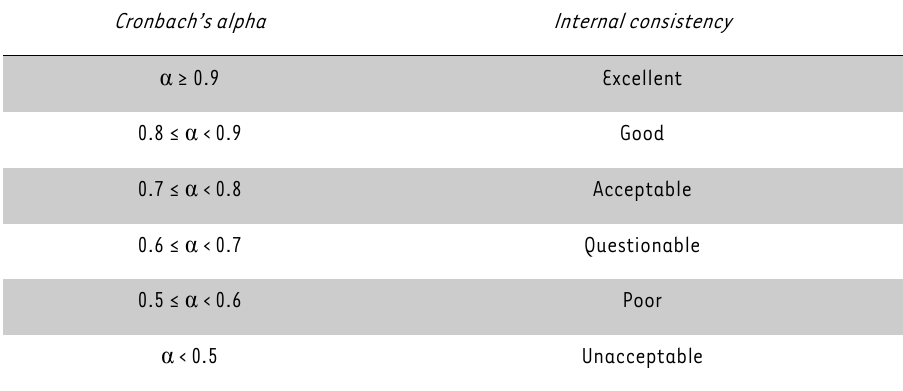
TABLE 4 indicates how Cronbach’s Alpha can be interpreted. Even though the Cronbach Alpha value for Factor 3 was low, a decision was made to include it in the analysis, since the factor does correlate with a possible factor that was initially identified. TABLE 4: Rule of thumb in interpreting Cronbach’s